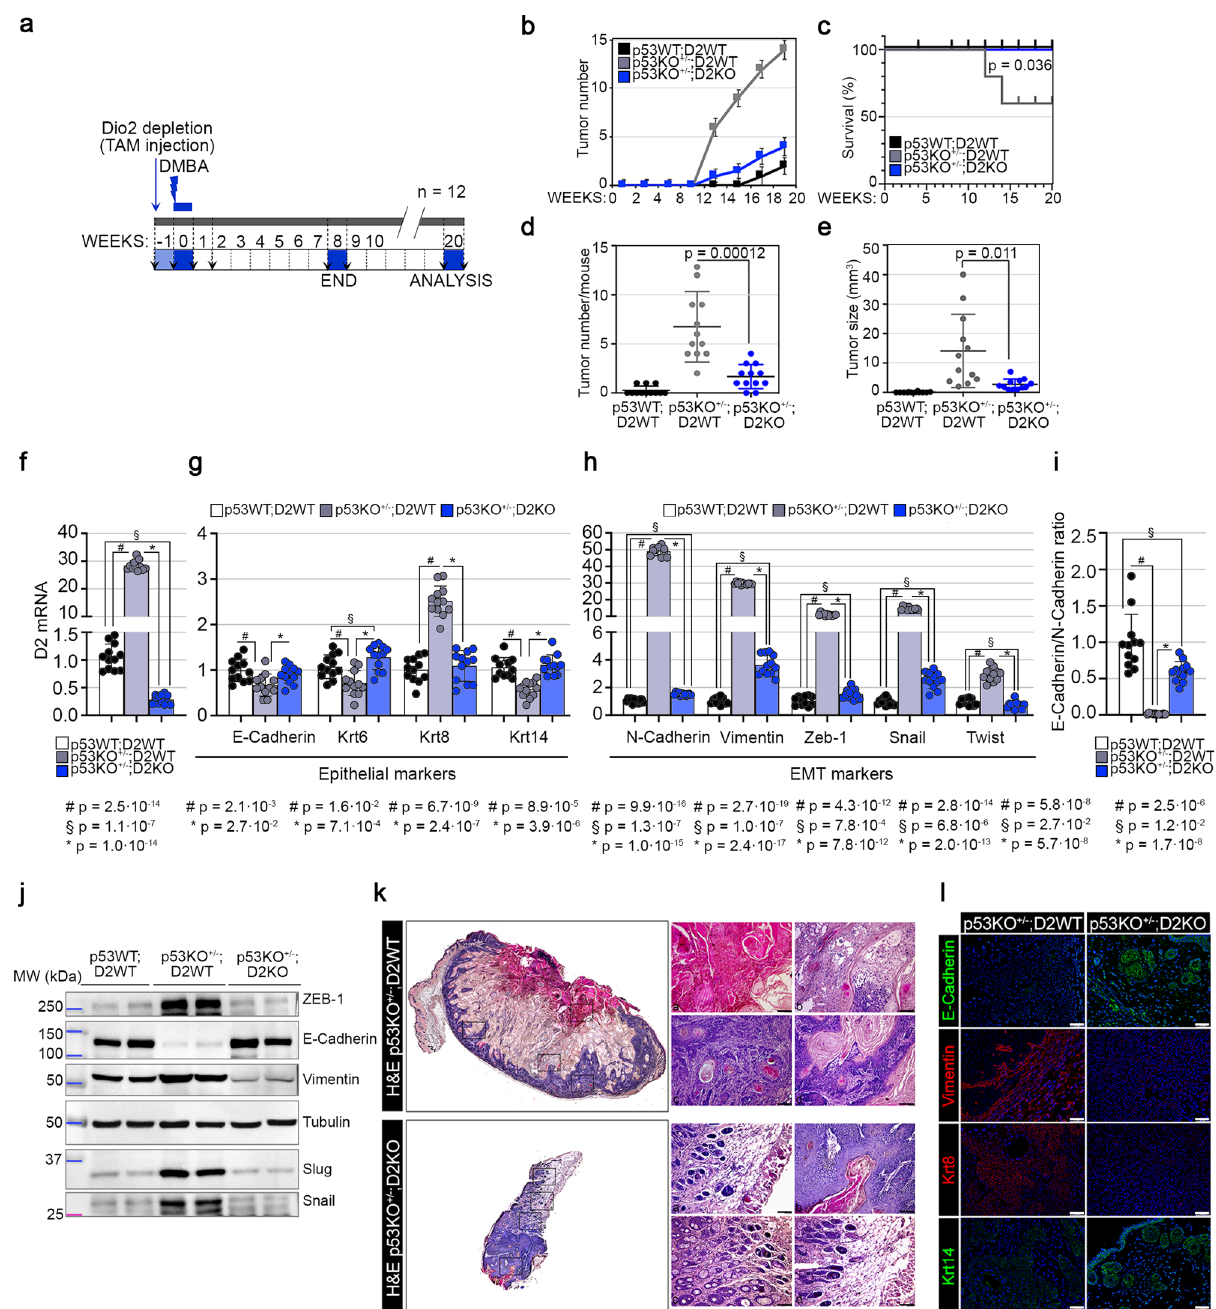
Fig. 3 | Epidermal attenuation of TH signaling reduces the p53-dependent tumorigenesis. a Schematic representation of the two-step chemically induced carcinogenesis experiments. b – e Tumor number ( b ), percentage of survival ( c ), tumor number/mouse ( d ), and tumor size ( e ) were analyzed during the two-step chemically induced carcinogenesis experiments in (i) p53WT;D2WT, (ii) p53KO +/ − ; D2WT andiii) p53KO +/ − ;D2KOmice( n =12 mice/group). f D2mRNAexpression was measuredbyReal-TimePCRinSCCtumorsfromdorsalskinof(i)p53WT;D2WT,(ii) p53KO +/ − ;D2WT and iii) p53KO +/ − ;D2KO mice ( n =12 mice/group). g – i mRNA expression of epithelial ( g ) and mesenchymal ( h ) markers and their ratio ( i ) was measuredbyReal-TimePCRinSCCtumorsfromdorsalskinof(i)p53WT;D2WT,(ii) p53KO +/ − ;D2WT and (iii) p53KO +/ − ;D2KO mice. j , Western Blot analysis of epithelial (E-Cadherin) and mesenchymal (Vimentin, ZEB-1, Snail, Slug) proteins in SCC